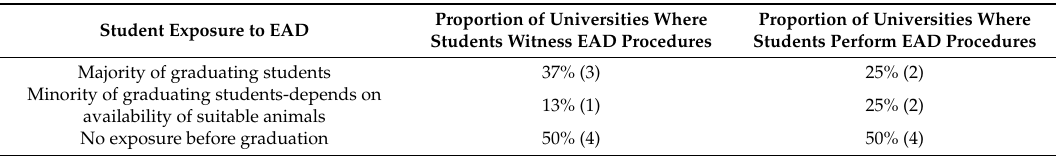
Table 6. Distribution of eight Australian veterinary schools by opportunities for their veterinary students to see and or perform EAD before graduation in 2015 1